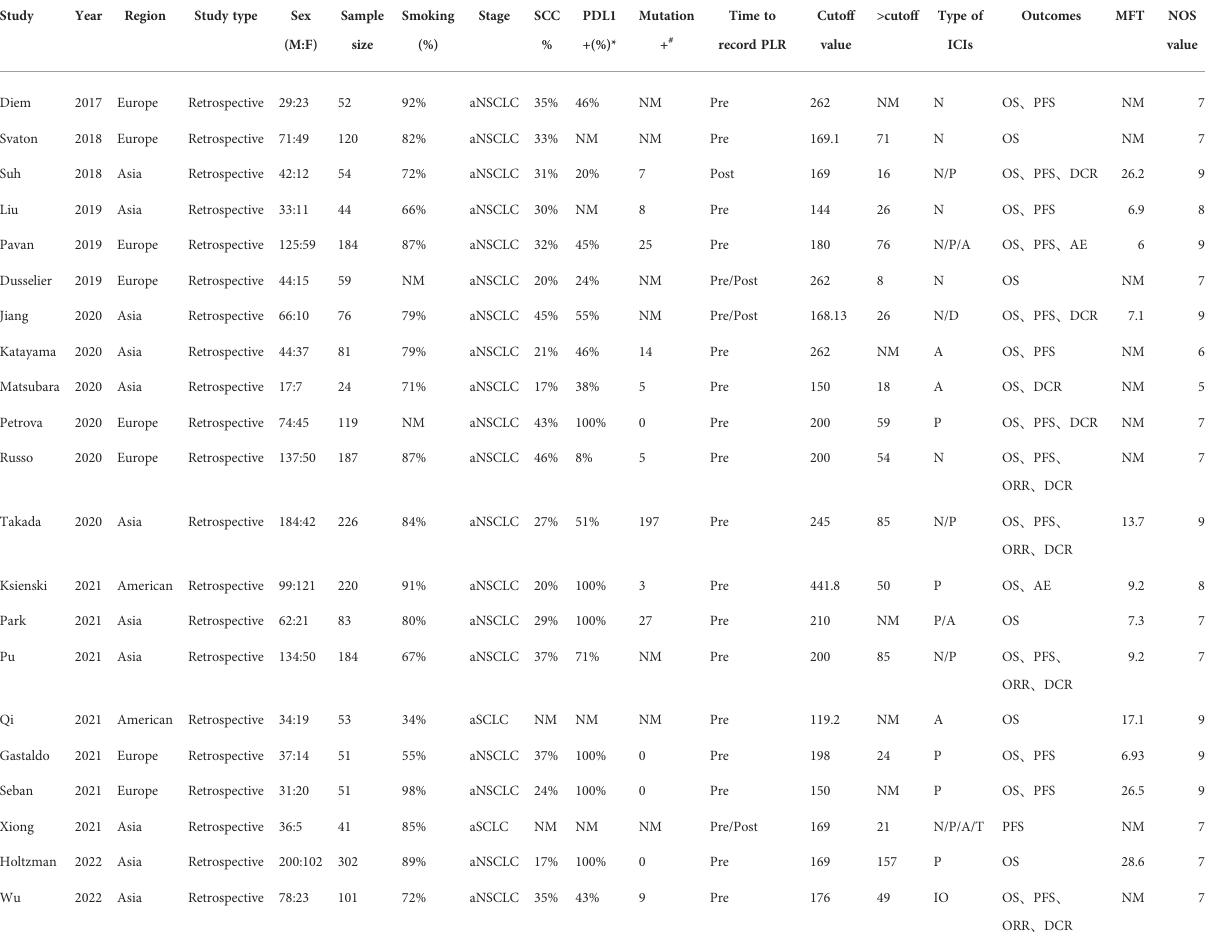
TABLE 1 Baseline characteristics of the included retrospective